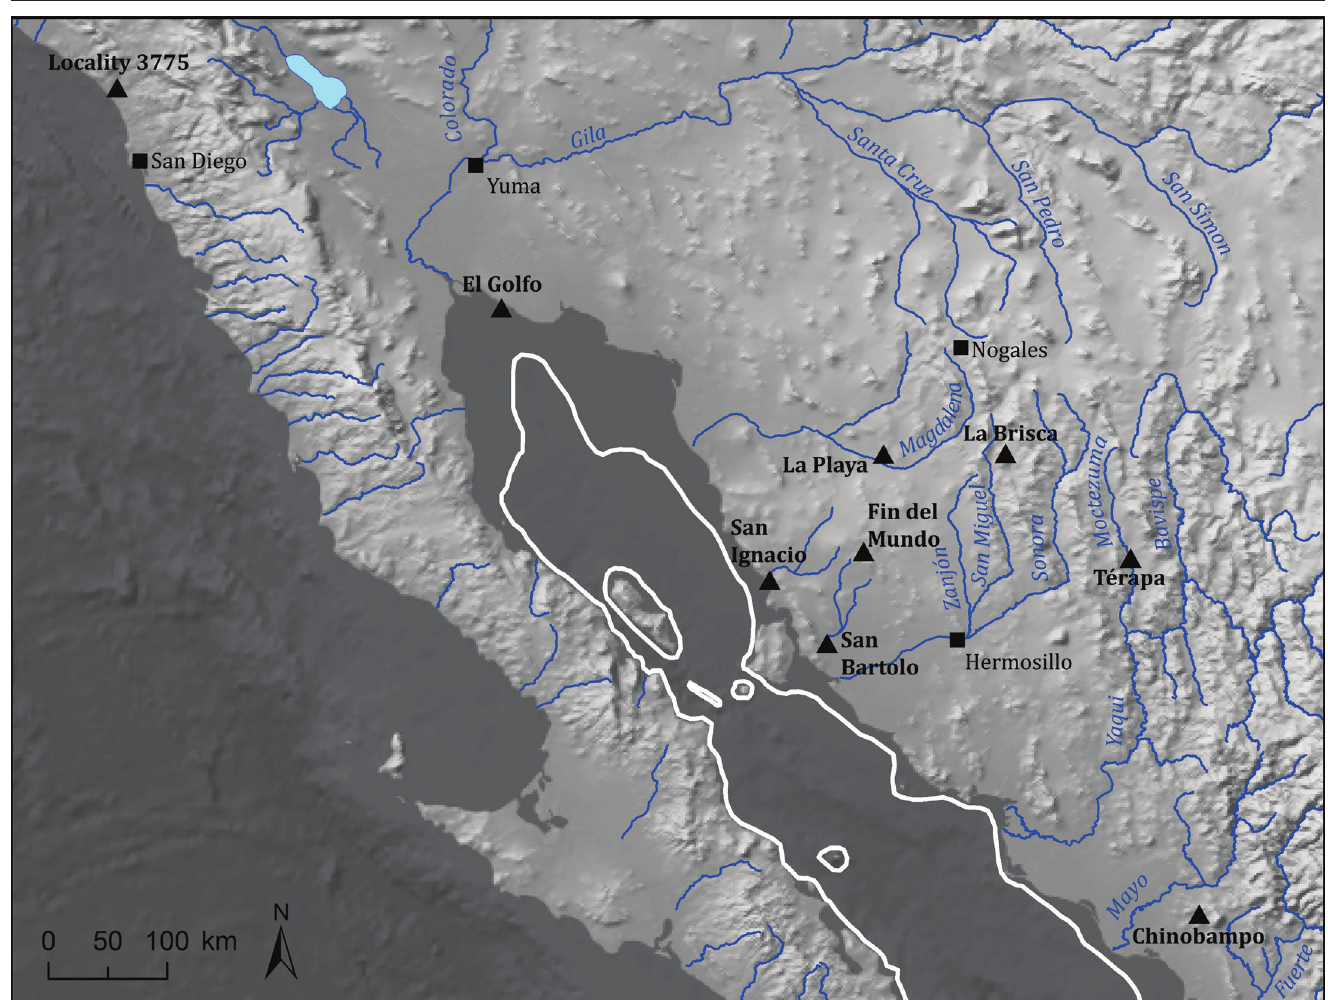
Figure 3. Map of northwestern México and southwestern United States, showing key cities for landmarks (solid square) and key paleontological sites mentioned in the text (solid triangles). Major river valleys indicated and labeled. Glacial maximum shoreline indicated by white line, based on bathymetry. The US/Mexico border is approximated by the location of San Diego, Yuma and Nogales. Map courtesy of Matthew C. Pailes, Department of Anthropology, University of